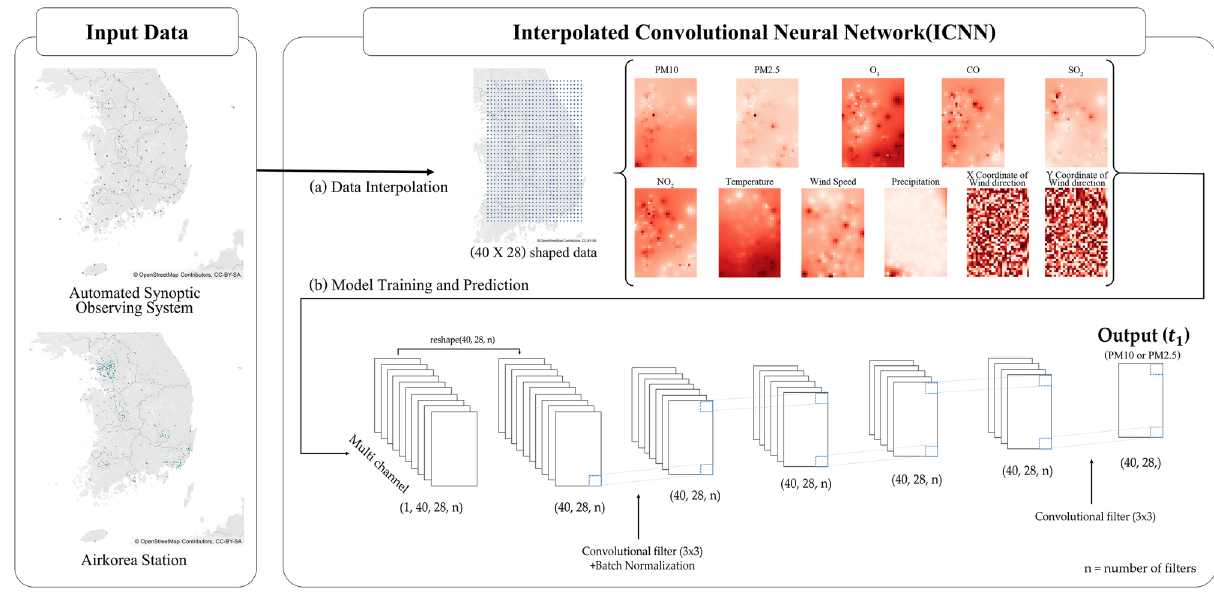
Figure 3. Overall flow of the ICNN prediction model. Map image is obtained from OpenStreetMap (openstreetmap.org) and licensed under CC-BY-SA (https:// www. opens treet map. org/ copyr mal combination of parameters. For this step, we used ReLU and scaled exponential linear unit as the activation functions. These functions are robust to gradient vanishing, which has been identified as a problem in neural networks. In addition, among the optimizers for weights in neural networks, we used Adadelta, Adam, and SGD optimization algorithms. After multiple attempts, we selected ReLU and Adam as optimal learning parameters, a batch size of 512, epoch of 2000, mean squared error for loss function, and early stopping to prevent overfit- ting. Furthermore, we enhanced the model’s performance by using batch normalization. We used the OLS and LSTM models as comparison groups for the ICNN prediction model. The comparison models were configured to predict a total of 1120 points (40 × 28 = 1120), which is the same as the output of the ICNN prediction model. Evaluation metric. R‑squared. R-squared is an indicator used to evaluate the explanatory power of spatial and temporal prediction models 45 . In this study, the R-squared value was derived by performing an ordinary least squares regression using the PM10 and PM2.5 concentration levels measured and predicted by the ICNN prediction model as independent variables and the hourly measured, actual PM10 and PM2.5 concentrations as dependent variables. The derived R-squared value was used as the explanatory power indicator of the prediction model. Root mean squared error (RMSE). The RMSE is the mean error between the predicted value and the measured value. It is one of the most frequently used evaluation indicators to represent the general performance of predic- tion models 19,21,26,45 . The closer to zero the RMSE value, the better the prediction model. In this study, the per- formance of the prediction model was evaluated by calculating the mean error between the air quality variable concentration predicted by the ICNN prediction model and the collected data. Verification of high concentration. The fine dust(PM10) high concentration criterion of 80 µg or higher and the ultrafine dust(PM2.5) high concentration criterion of 35 µg were classified as high concentrations as per the Republic of Korea Ministry of Environment. The following evaluation indicators were used for evaluating high PM10 and PM2.5 concentrations 13,46,47 : probability of detection (POD), false alarm rate (FAR), true skill score (TSS), and critical success index (CSI). In Table 1, the contingency table needed for using each indicator in binary classification 48 is presented. If the forecast is accurate, the possible cases are "Hit" and "Correct rejection"; if the forecast is not accurate, the pos- sible cases are "False alarm" and "Miss." The overall accuracy of the prediction model is good if the "Hits" and "Correct rejections" are predominant, with a few "False alarms" and "Misses." The equations for POD, FAR, CSI, and TSS, using the parameters shown in Table 2, are as follows: